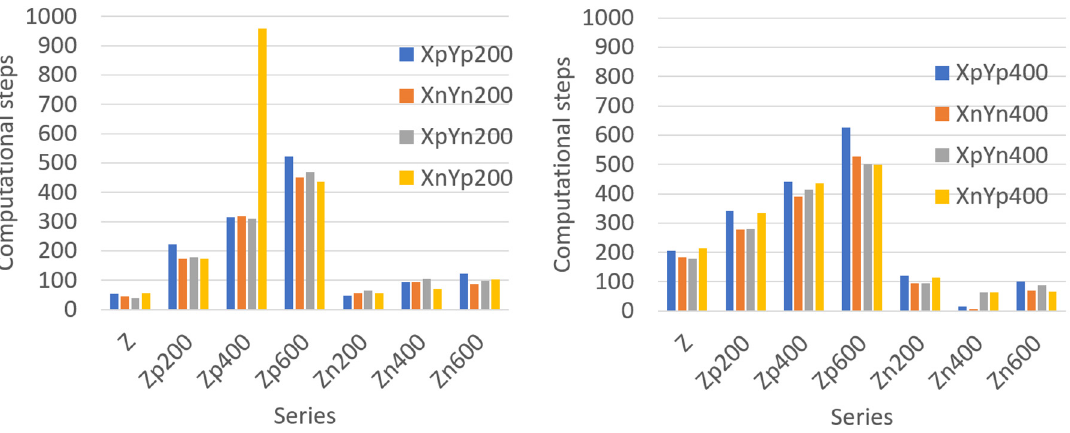
Figure 8. Computational steps in series under tri ‐ directional mode for SB2 model ( left ) series XY200 and ( right ) series XY400.